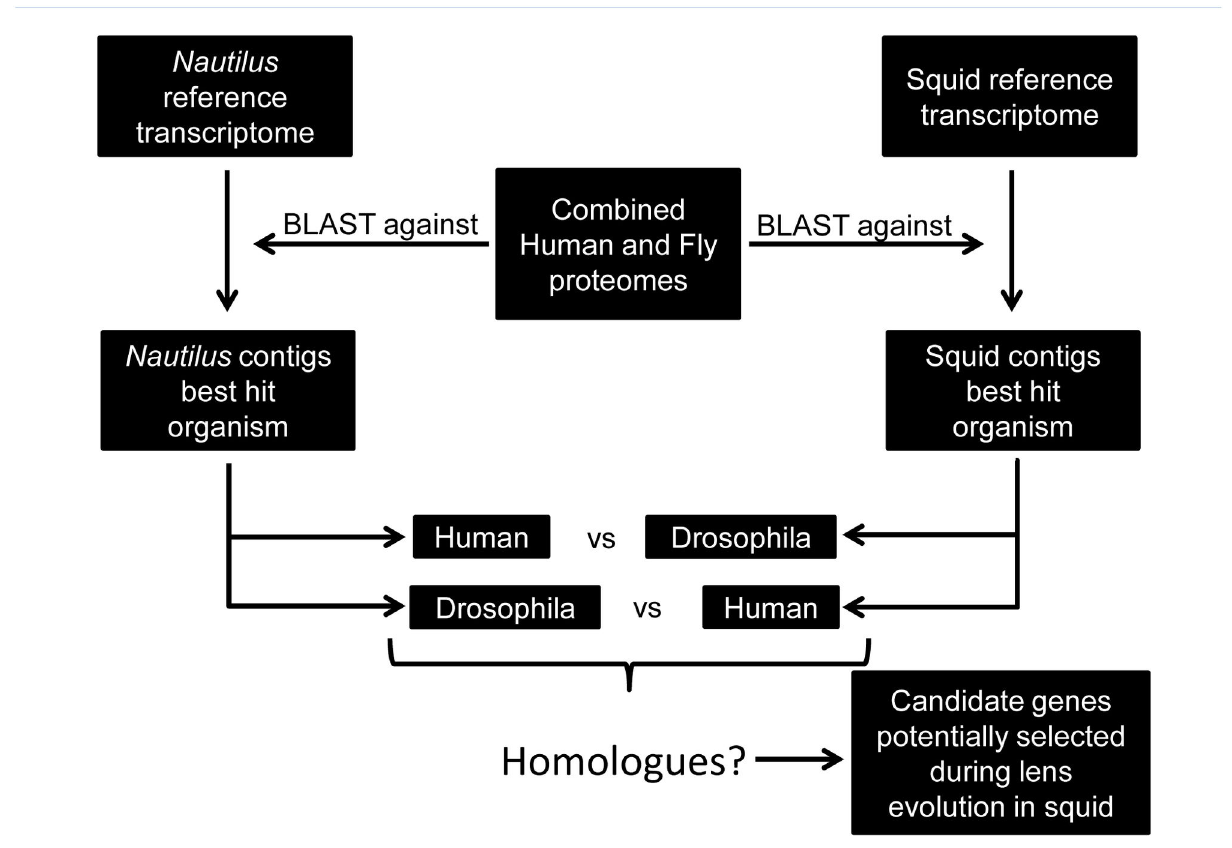
Figure 4. Work flow to find candidates selected for lens evolution in squids. Nautilus and squid transcriptomes were compared with a combined Human and Drosophila proteome. Contigs between Nautilus and squid that shared a homologue gene in Drosophila and Human were further